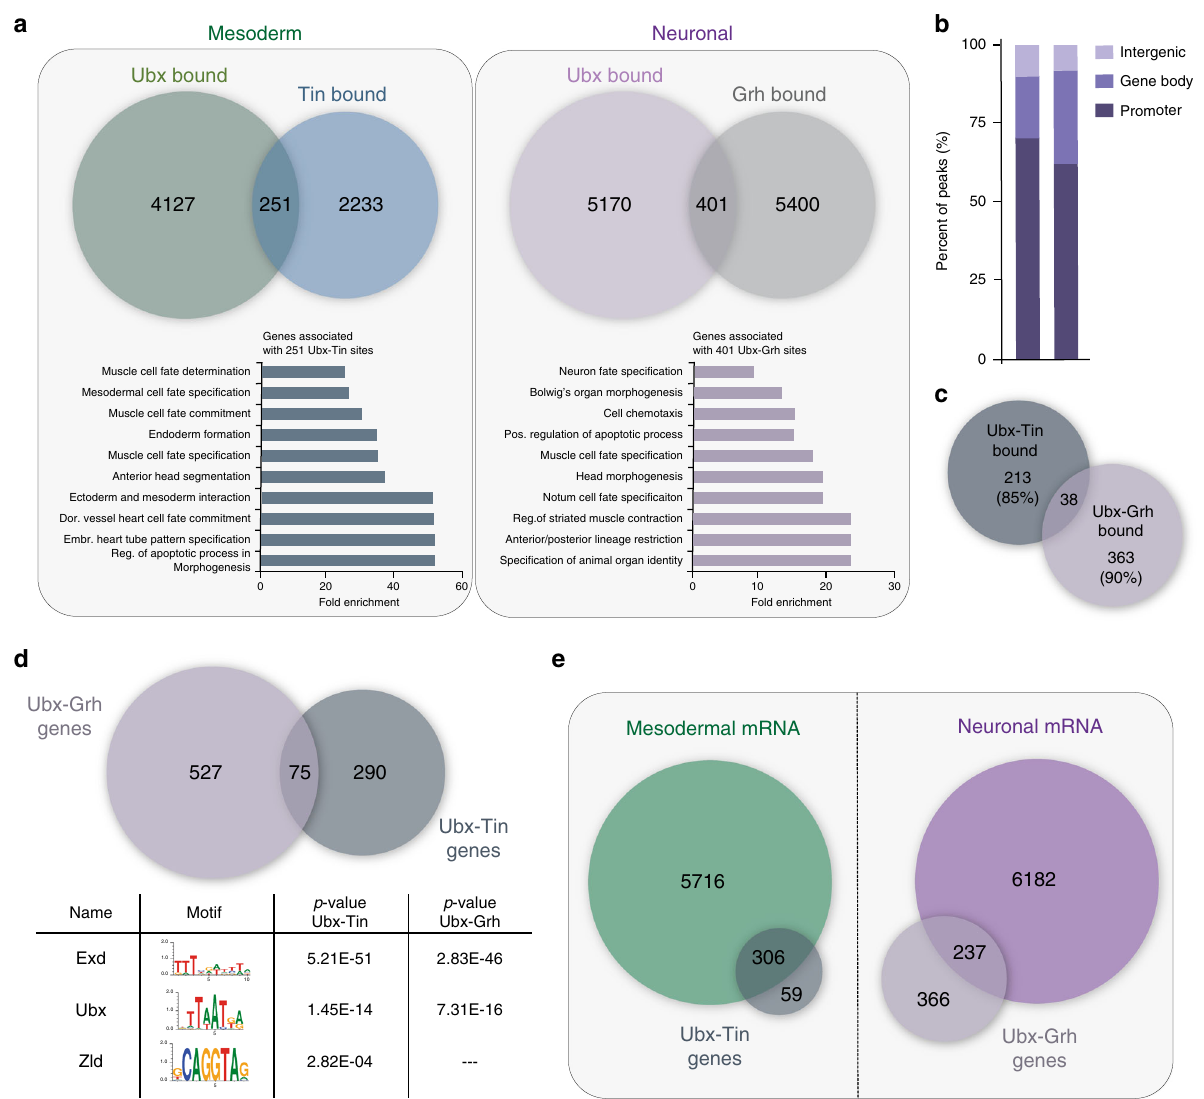
Fig. 4 Interplay between Ubx and the lineage-restricted TFs Tin and Grh. a Left panel: Venn diagram representing the overlap of genomic regions (1 kb) bound by Ubx (mesoderm ChIP-seq 2 ) and Tin (ChIP-on-ChIP 45 ). 251 regions are co-bound by Ubx and Tin in the mesoderm, which are located in the vicinity of 367 genes. Fold enrichment of gene ontology terms of genes commonly bound by Ubx and Tin in the mesoderm. Right panel: Venn diagram representing the overlap of genomic regions (1 kb) bound by Ubx (neural ChIP-seq 2 ) and Grh (ChIP-seq 46 ). 401 regions are co-bound by Ubx and Grh in the nervous system, which are located in the vicinity 604 genes. Fold enrichment of gene ontology terms of genes commonly bound by Ubx and Grh in the nervous system. b Graphical representation in percentage of the genomic localisation of region bound in common by Ubx-Tin and Ubx-Grh classi fi ed into promoter regions ( − 2 kb from TSS), gene bodies (5 ′ -UTR, exon, intron, 3 ′ UTR), and intergenic regions. c Venn diagram representing the overlap of genomic regions (1 kb), which are bound by Ubx-Tin and Ubx-Grh. Only 38 regions are bound by both TF combinations revealing a distinct signature of Ubx-Tin (85% exclusive) and Ubx-Grh (90% exclusive) bound cis -regulatory elements. d Top panel: Venn diagram representing the overlap of genes bound by Ubx and Tin in the mesoderm and by Ubx and Grh in the nervous system. Bottom panel: Representative motifs identi fi ed by AME motif search (MEME suite) within 1 kb region co-bound by Ubx and Tin in the mesoderm and Ubx and Grh in the nervous system. e Venn diagrams representing the overlap of genes bound by Ubx and Tin with the mesodermal transcriptome (mesodermal RNA-seq 2 ) (left panel) and genes bound by Ubx and Grh with the neural transcriptome (neural RNA-seq 2 ) (right panel). GO term and motif p -value are calculated with Fisher test. See also Supplementary Table 2 and Source Data fi le. Source data are provided as a Source Data fi functional cooperation of both TFs in vivo (Fig. 5i, Supplemen- tary Fig. 7b) and enhanced the interaction in cells (Supplemen- tary Fig. 6c, Supplementary Data 39).